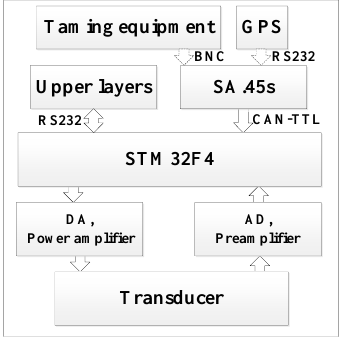
Figure 2. Hardware platform of the proposed modem.